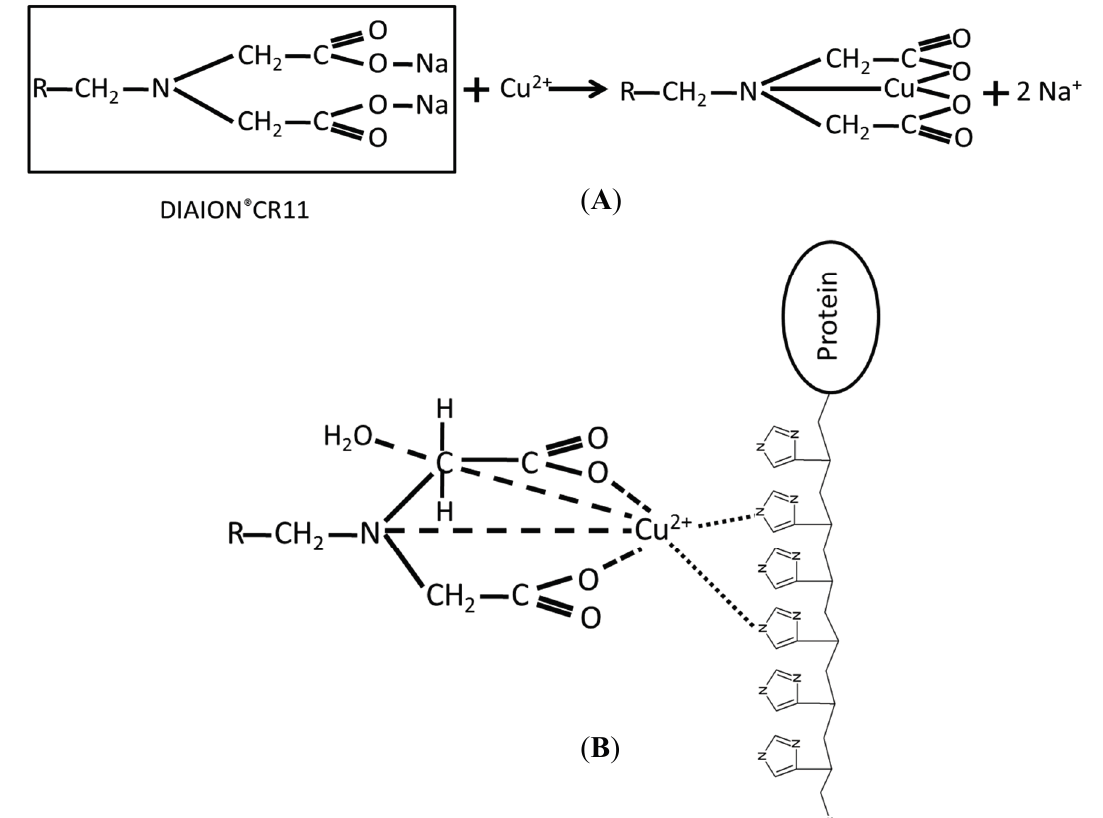
Figure 1. Schematic diagram showing how DIAION ® CR11 resin with chelated metal ions was used to capture poly (His)-tagged proteins. ( A ) The structure of the DIAION ® CR11 resin was chelated Cu(II) ions. ( B ) The structure of the DIAION ® CR11-chelate Cu(II) ions capture the poly (His)-tagged